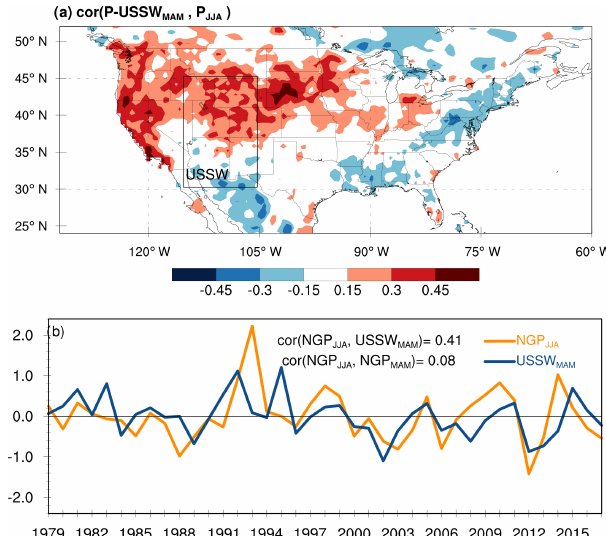
Figure 12. Single-point correlation map between standardized anomalies of MAM precipitation over the US SW region (30–45 ◦ N and 105–115 ◦ W) and JJA precipitation at each grid cell (a) . The time series of standardized anomalies of JJA precipitation over the NGP (yellow) and MAM precipitation in the US SW (blue) are shown in panel (b) . The CPC gauge-based precipitation from 1979 to 2018 was used to derive both the correlation map and time